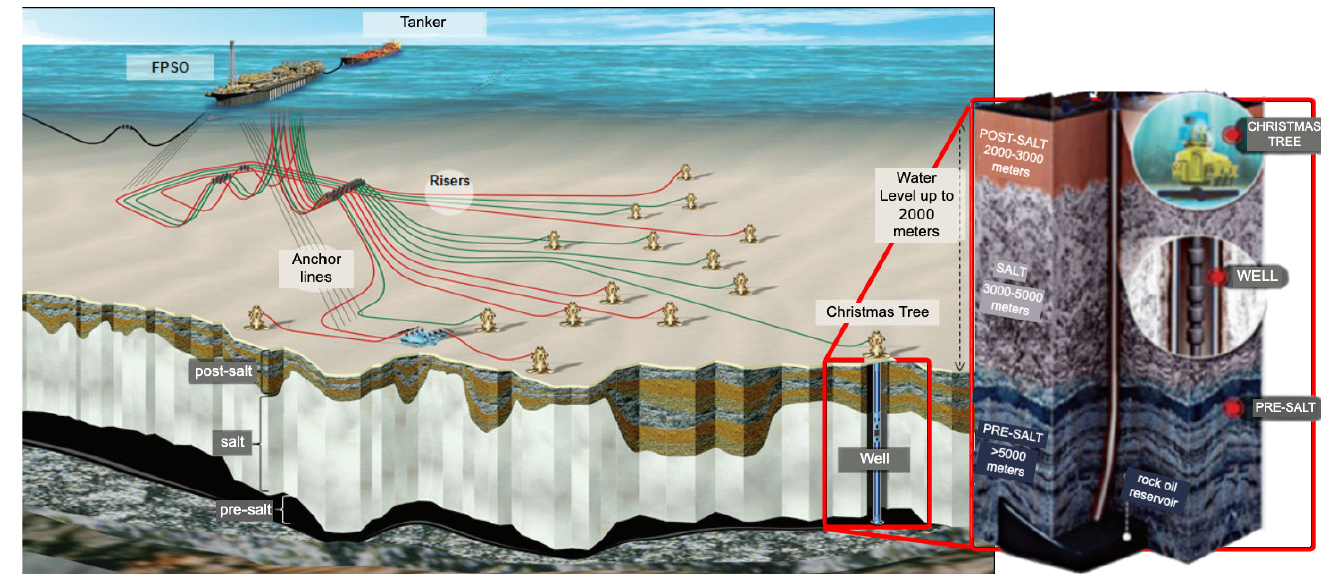
Figure 1. Graphic representation of FPSO and subsea systems.